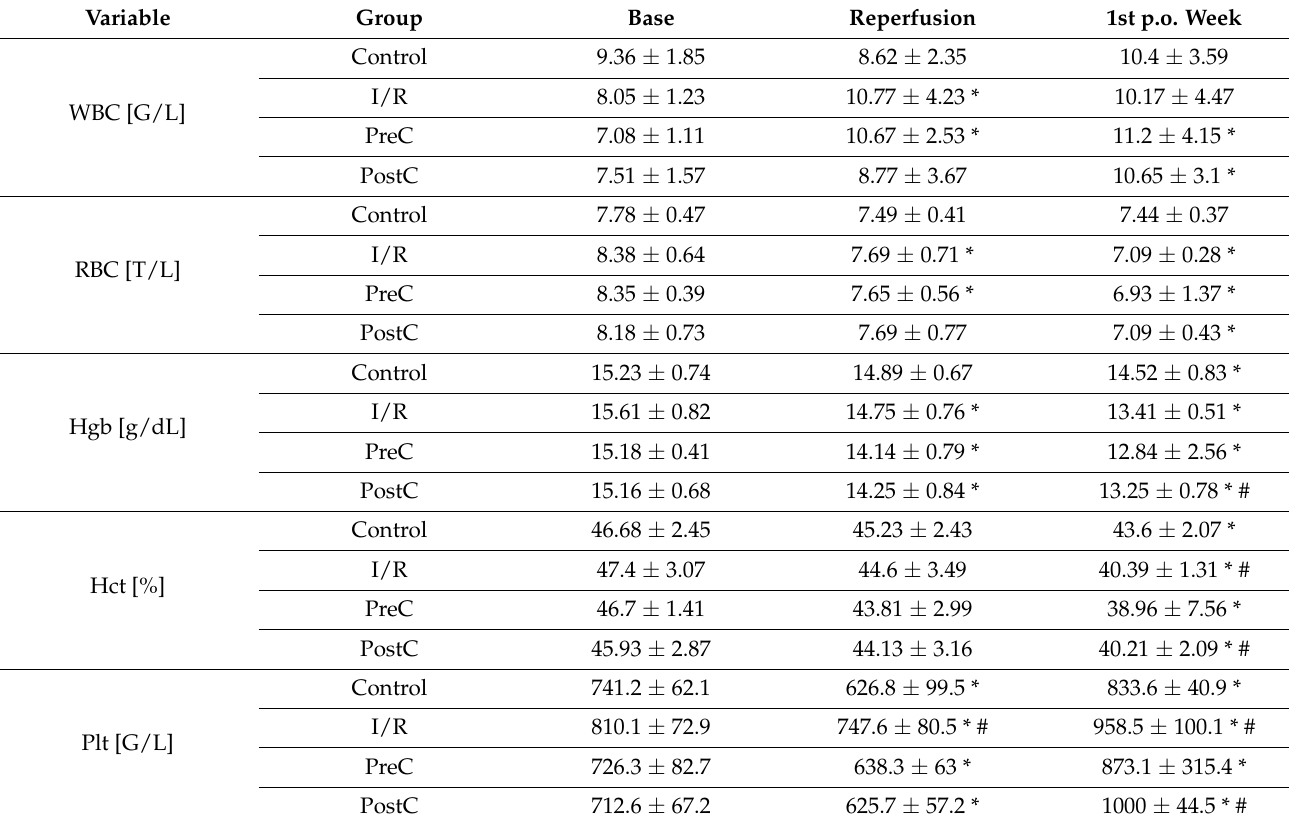
Table 1. Selected hematological parameters in the control, the ischemia-reperfusion (I/R), the ischemic pre-conditioning (PreC), and the ischemic post-conditioning (PostC) groups. Variable Group Base Reperfusion 1st p.o.